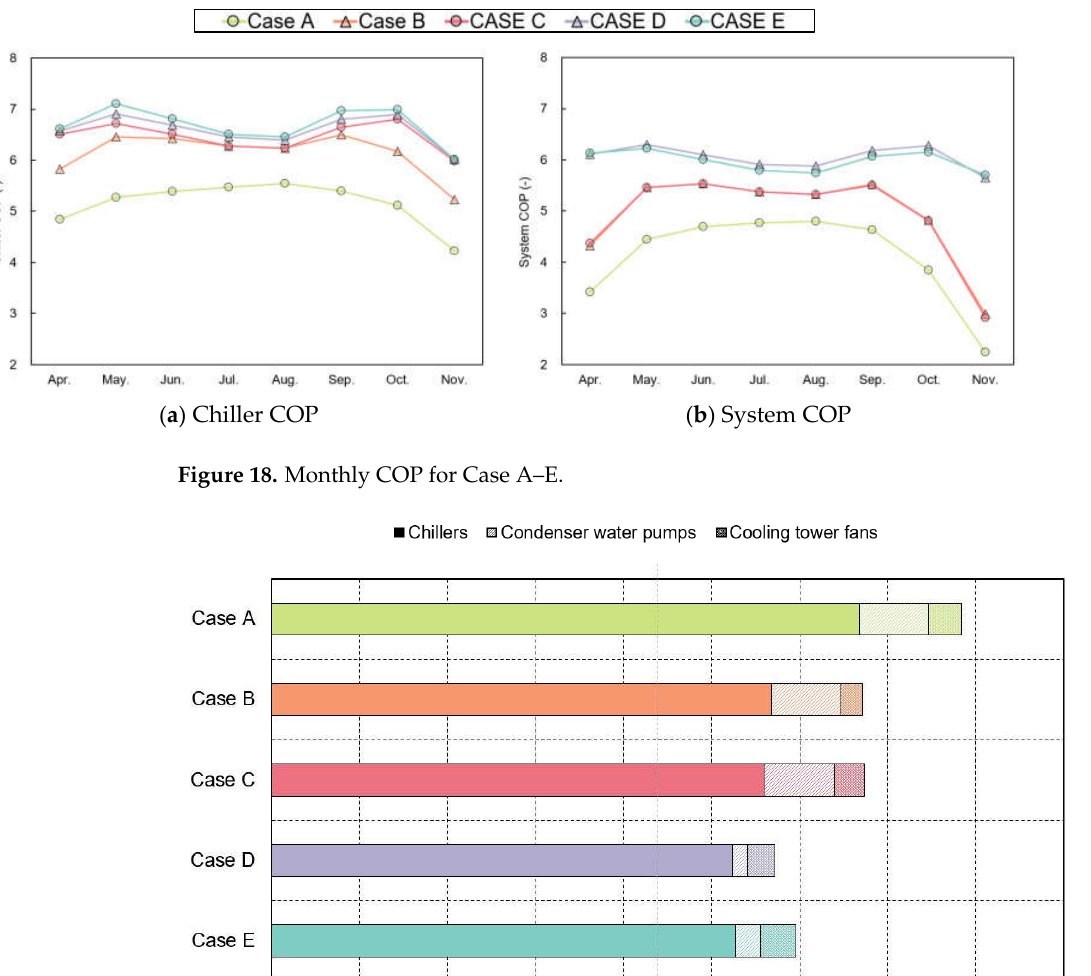
Figure 18. Monthly COP for Case A–E.